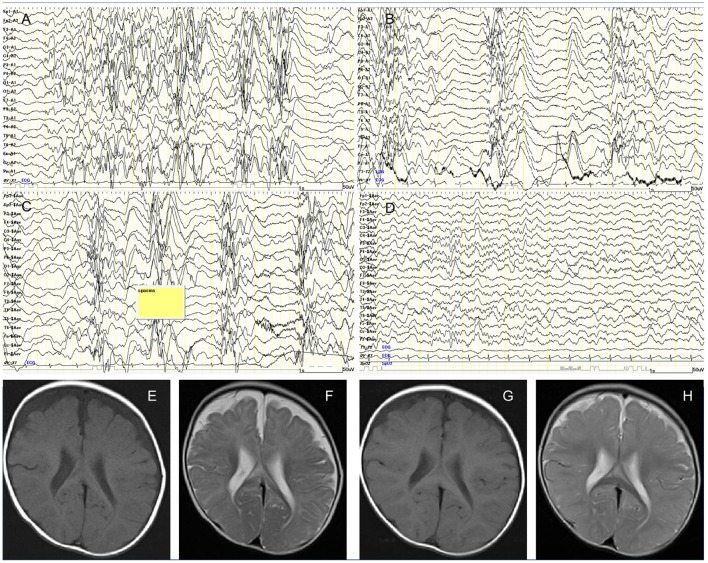
(A) Interictal awake electroencephalography at 7 months showing the characteristic random high-voltage slow waves with spikes and polyspikes activity. (B) Fragmentation of the hypsarrhythmic activity is noticed during sleep recording. (C) Ictal EEG recording showing a cluster of epileptic spasms with high amplitude slow wave at each spasm. (D) Sleep recording showed normalization of background EEG observed 2 months after treatment. (E) Axial T1-weighted image. (F) Axial T2-weighted image of cranial MRI before initiation of adrenocorticotropic hormone therapy at 7 months of age showing cerebral atrophy with frontal predominance and delay in myelination. Follow-up imaging after vitamin B12 supplementation at 14 months of age documenting improved delayed myelination and cerebral atrophy. (G) Axial T1-weighted image. (H) Axial T2-weighted image.